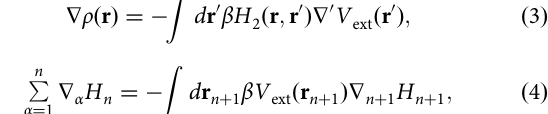
Fig. 2b. For small ϵ we can Taylor expand to linear order: V ext ( r + ϵ ) = V r ) + δ V r ), where δ V r ) = ϵ ⋅ ∇ V r ) indicates the ext ( ext ( ext ( ext ( local change of the external potential that is induced by the shift.